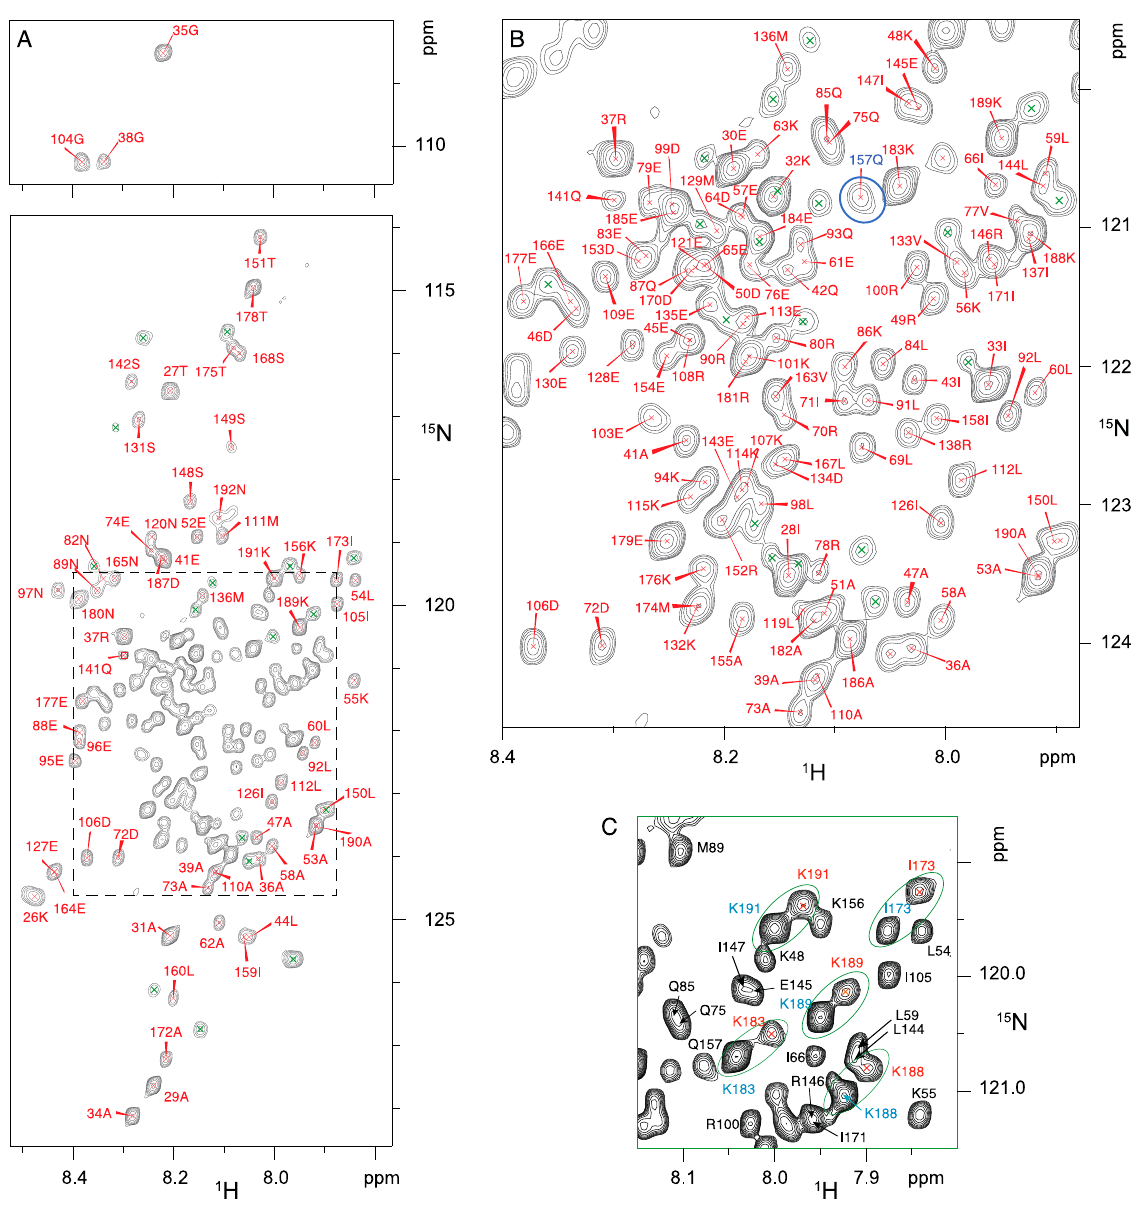
Figure 2. 1 H- 15 N BEST-TROSY spectrum of 970 µM 15 N- 13 C- 2 D-labeled Nter-BsRNaseY. The spec- trum was recorded at 950 MHz, in 40 mM MES buffer pH 6.8, 200 mM NaCl, 300K. ( A ) Overall spectrum and ( B ) enlarged view of framed region. Several peaks, such as Q157 (circled in blue), display a weak intensity. ( C ) Region of the 1 H- 15 N BEST-TROSY spectrum of Nter-BsRNaseY showing several duplicated peaks, marked in blue (higher intensity peaks) and in red (lower intensity peaks). Pairs of split peaks are circled in green. The peaks that are not duplicated are marked in black.